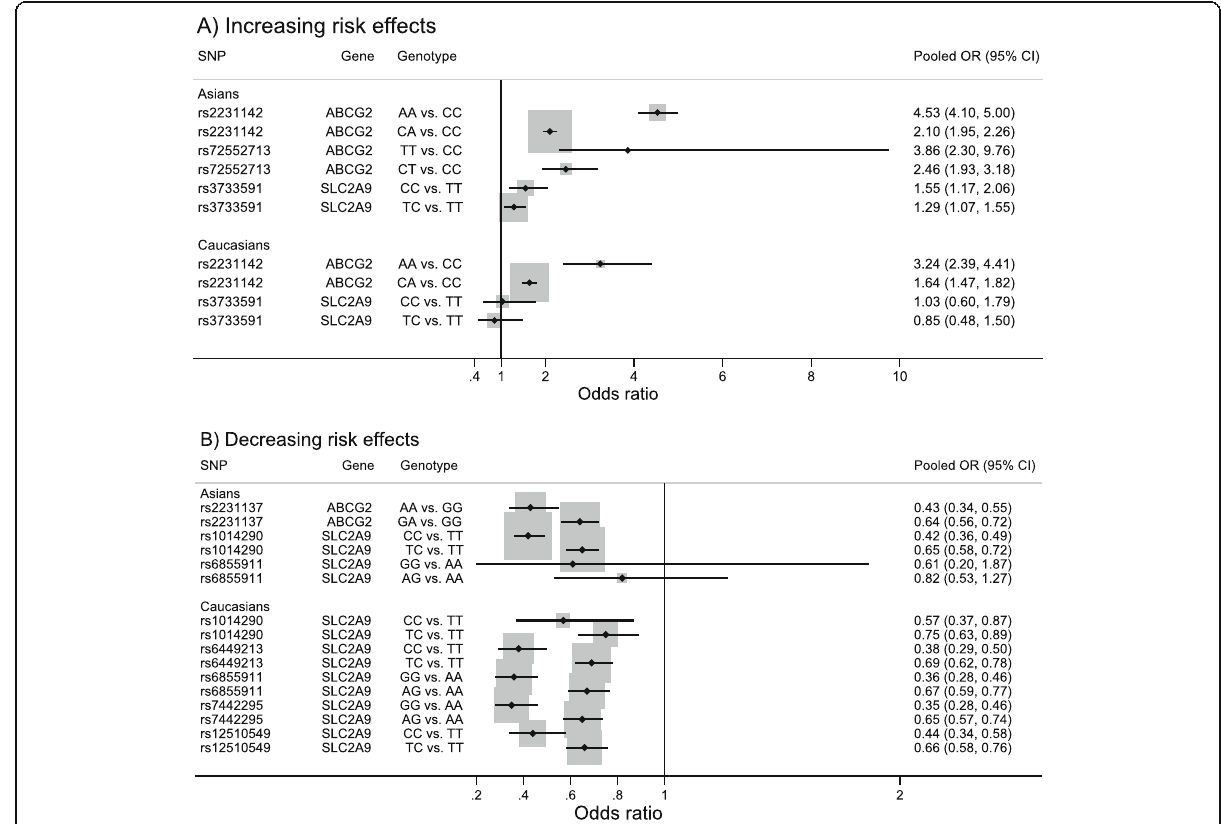
Fig. 2 Summary of pooled genotype effects on gout. a Increasing risk effects b Decreasing risk effects. ABCG2 , ATP-binding cassette sub-family G member 2; CI, confidence interval; OR, odds ratio; SLC2A9 , solute carrier family 2 member 9; SNP, single nucleotide